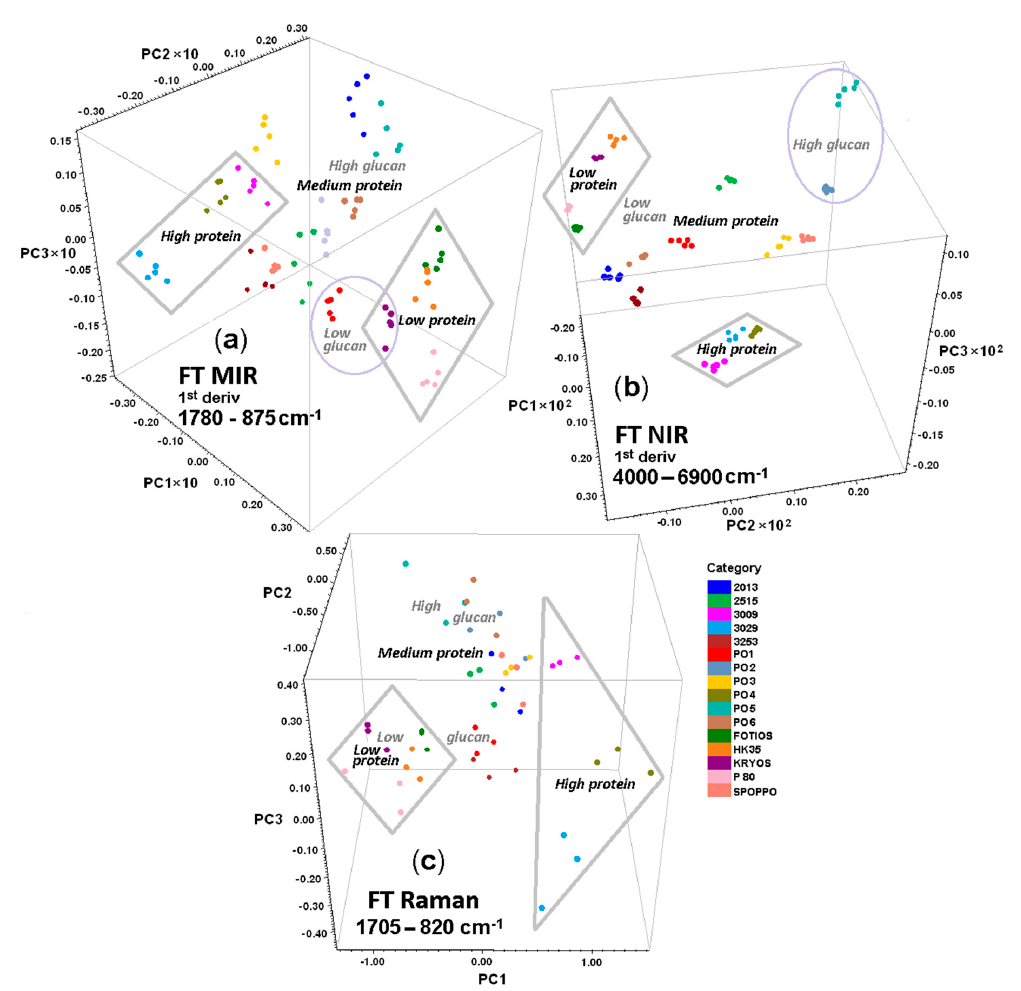
Figure 3. The 3D score plots of PC1 versus PC2 versus PC3 for the PCA of spectroscopic data: ( a ) FT MIR, ( b ) FT NIR and ( c ) FT Raman. Table 6. Parameters of the partial least squares regression (PLSR) models.